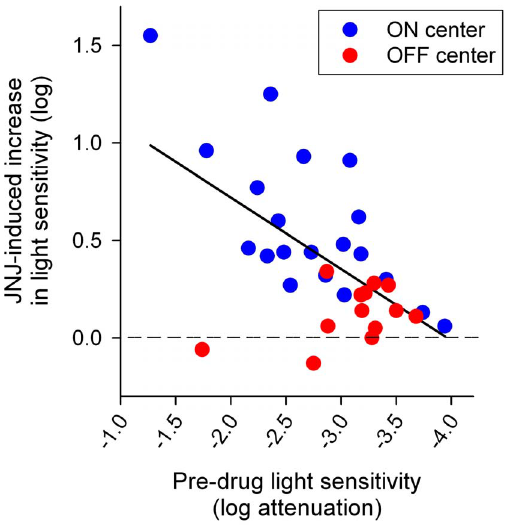
Figure 2. Comparison of JNJ16259685-induced increase in light sensitivity and pre-drug light sensitivity of P23H rat RGCs. Measurements from individual ON-center RGCs (n=20) and OFF- center RGCs (n= 13) are represented by blue and red circles, respectively. The solid line indicates the linear regression fit of all data points. Pearson’s correlation coefficient was 0.585 (P ,